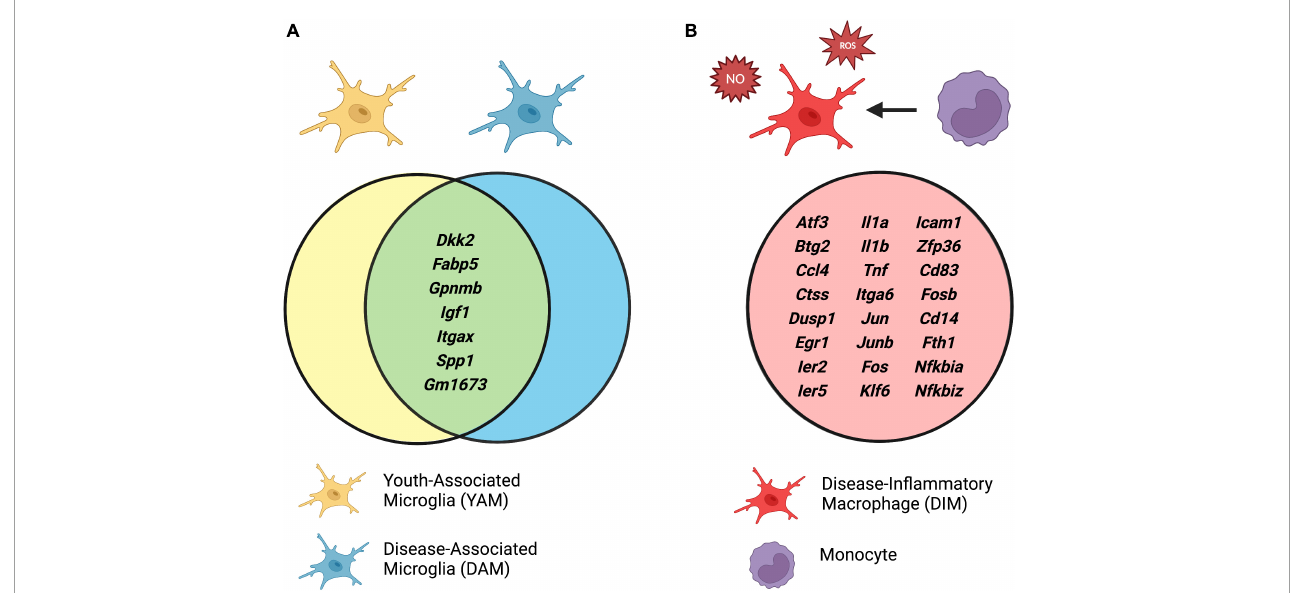
FIGURE2 (A) Conserved gene expression between disease-associated microglia (DAMs) and youth-associated microglia (YAMs), and (B) unique expression profile of disease-inflammatory macrophages (DIMs). Identified by integrated single cell RNA sequencing analyses of isolated brain myeloid cells in mouse models of Alzheimer’s disease (AD) and aging. Adapted from Silvin et al. (2022). Created with